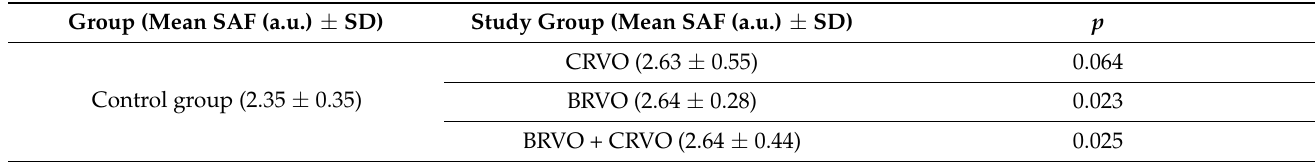
Table 2. Mean SAF value correlation between the BRVO group, CRVO group, and control group. Group (Mean SAF (a.u.) ±